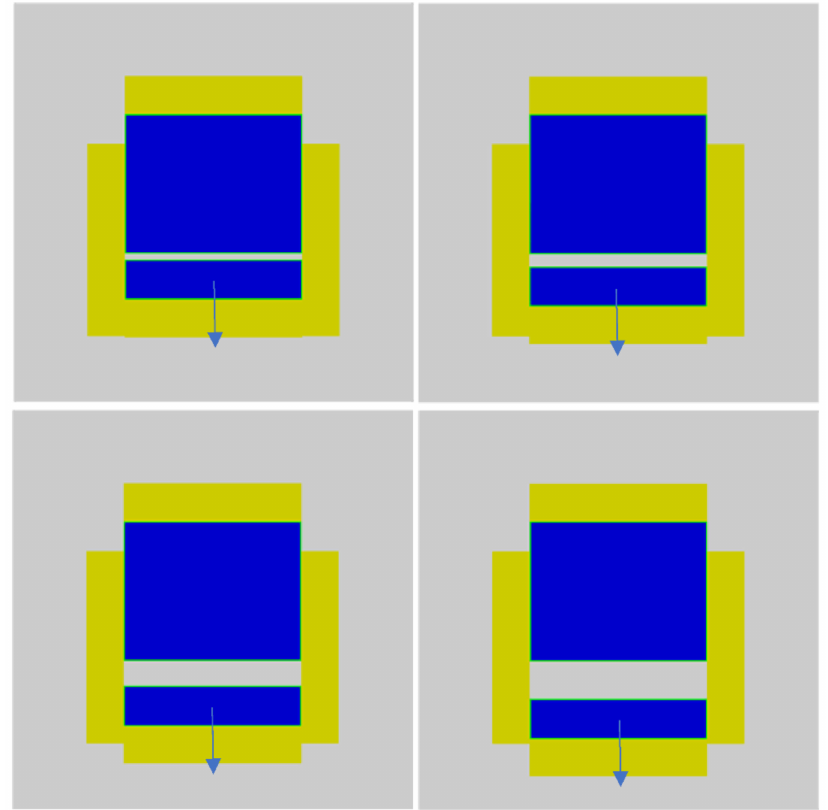
Figure 13. Shutdown system opening steps with increasing opening of the gap in the core from top left to bottom right (top left 5 cm, top right 10 cm, bottom left 20 cm, and bottom right 30 cm) analyzing the critical system (30 cm case with 140 cm diameter and 140 height, reflector position − 29